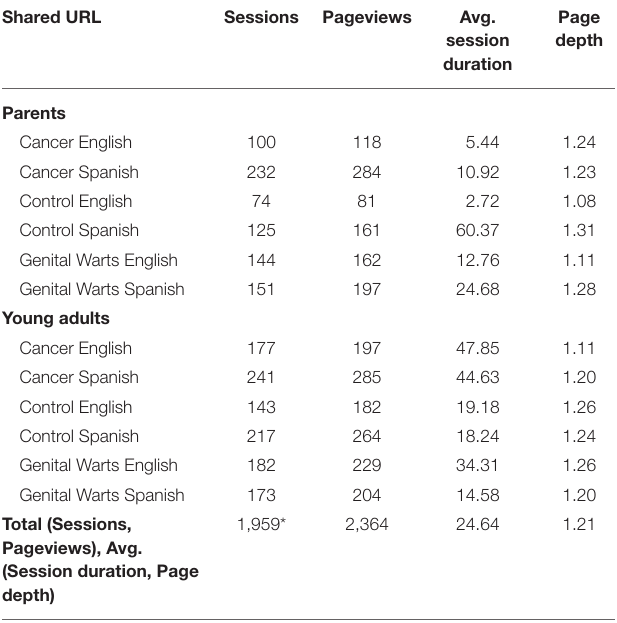
TABLE 3 | Google analytics